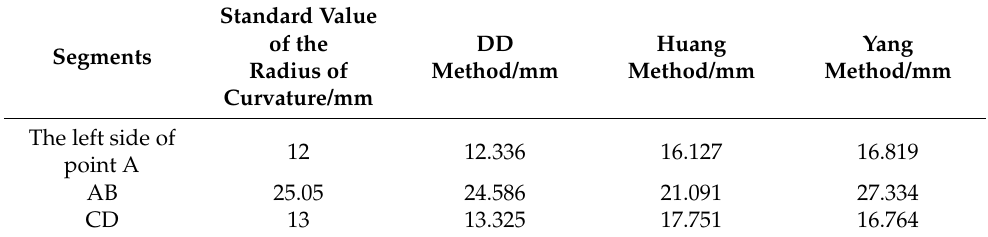
Table 5. The results of calculating LM c -type profile’s radius of